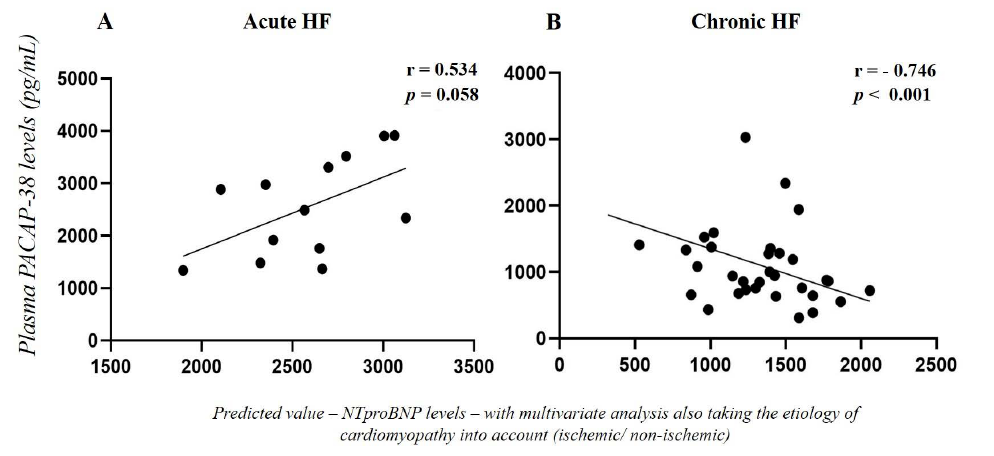
Figure 2. Correlation between the predicted value of NT-proBNP and plasma PACAP-38 levels (pg/mL) in acute ( A ) ( n = 13) and chronic ( B ) ( n = 33) heart failure (HF) with multivariate analysis, also taking the etiology of cardiomyopathy into account (ischemic or non-ischemic). Statistical analysis was performed with Spearman’s